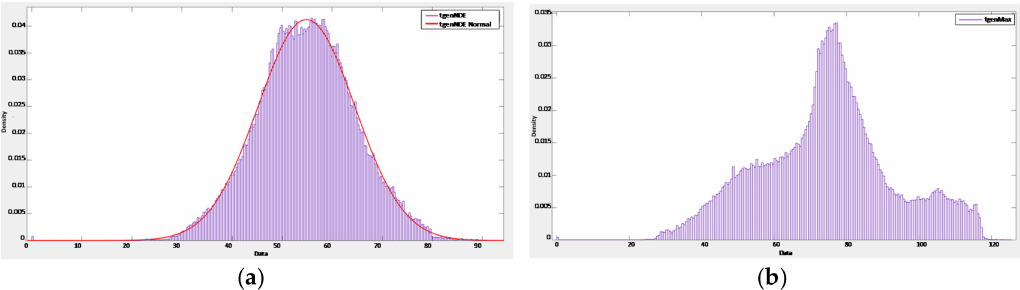
Figure 3. ( a ) Normal distribution of the NDE bearing temperature. ( b ) Non-normal temperature distribution of the generator